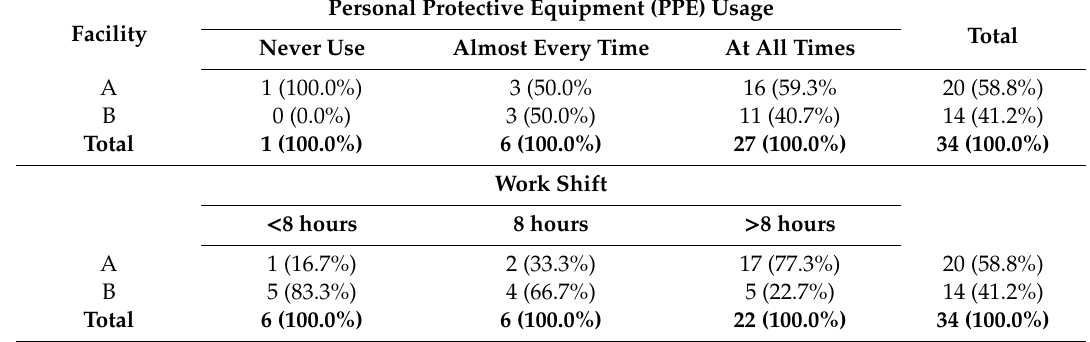
Table 2. Cross tabulation of personal protective equipment (PPE usage (with % within usage) and work shift (with % within each work shift) for each facility.